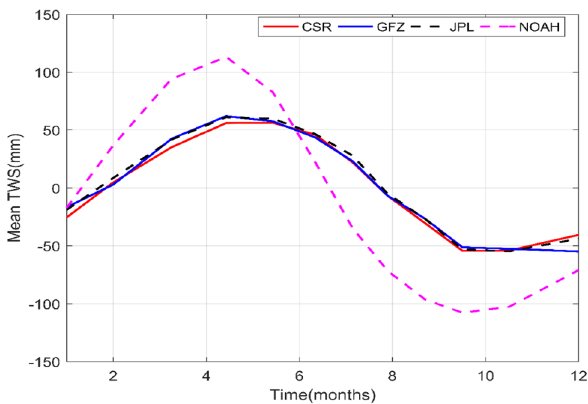
Fig. 3 Residuals of mean monthly TWS changes for GB calculated from GRACE (CSR, GFZ, JPL) and GLDAS-Noah model for